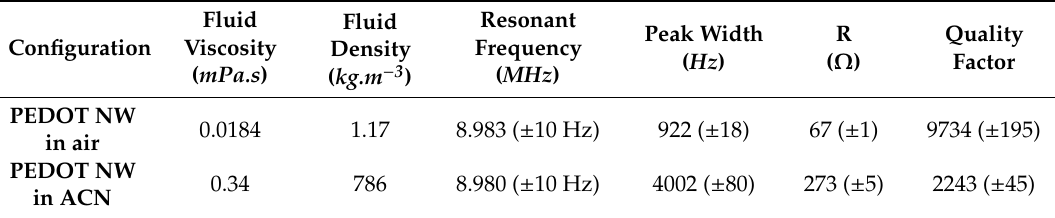
Table 1. Values obtained for the resonant frequency, peak width at half height, resistance (R) and quality factor (Q) for a quartz resonator with Au electrodes covered with PEDOT nanowires (NWs) in air and in